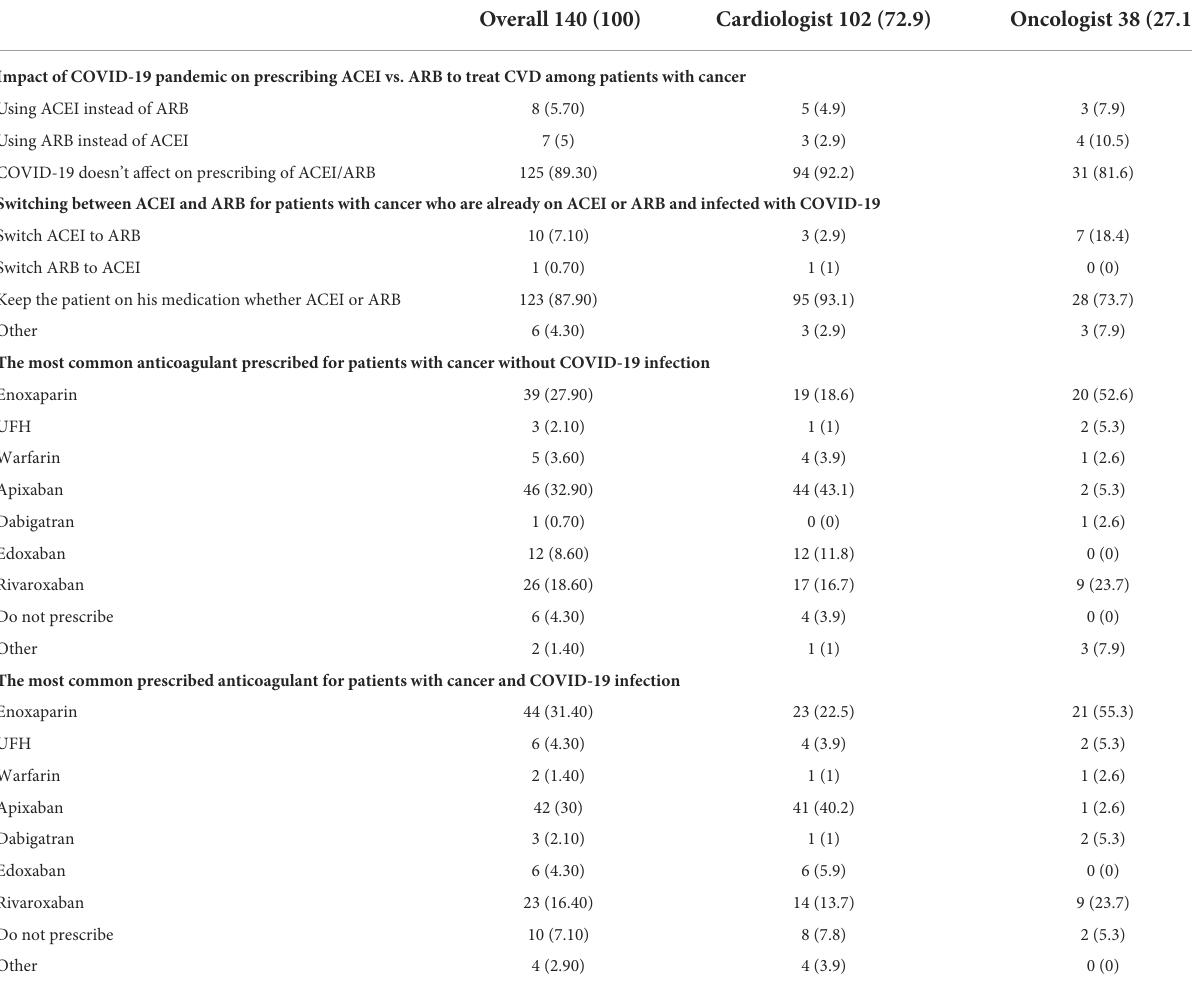
TABLE 3 Impact of COVID-19 pandemic on the selection of cardiovascular drugs in